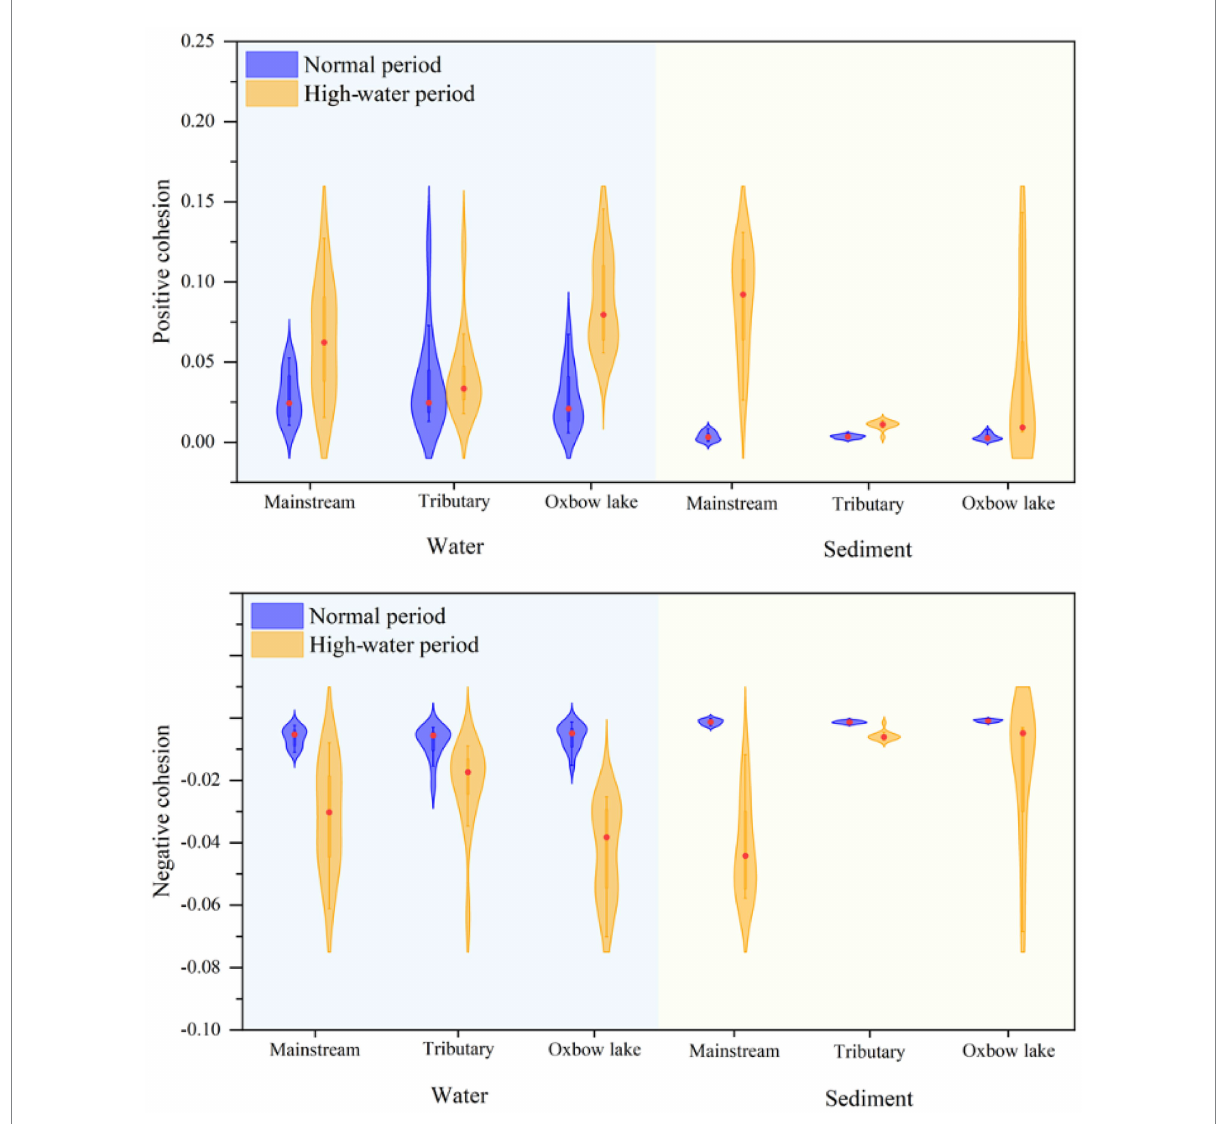
FIGURE 7 Cohesion metric of bacterial communities in water and sediment samples of the mainstream, tributaries, and oxbow lakes between two different